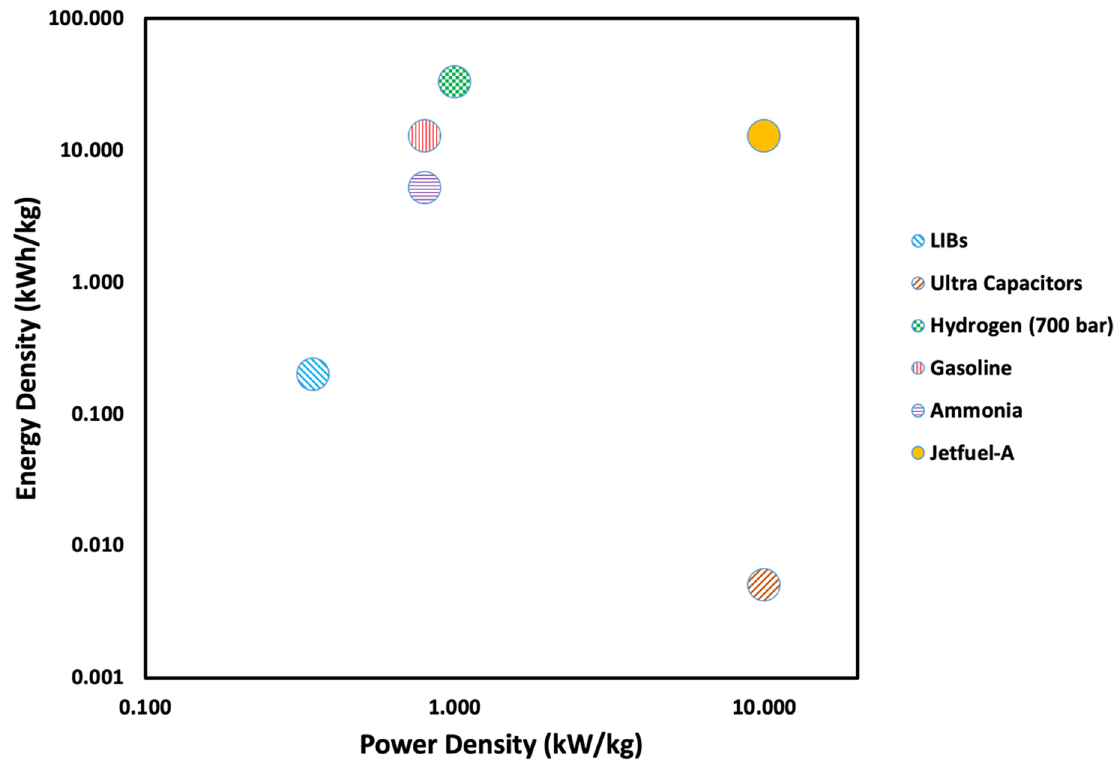
Figure 1. Ragone plot of current LIB, hydrogen, gasoline, ammonia and jet fuel—energy storage solutions in comparison to traditional industrial ultracapacitors.